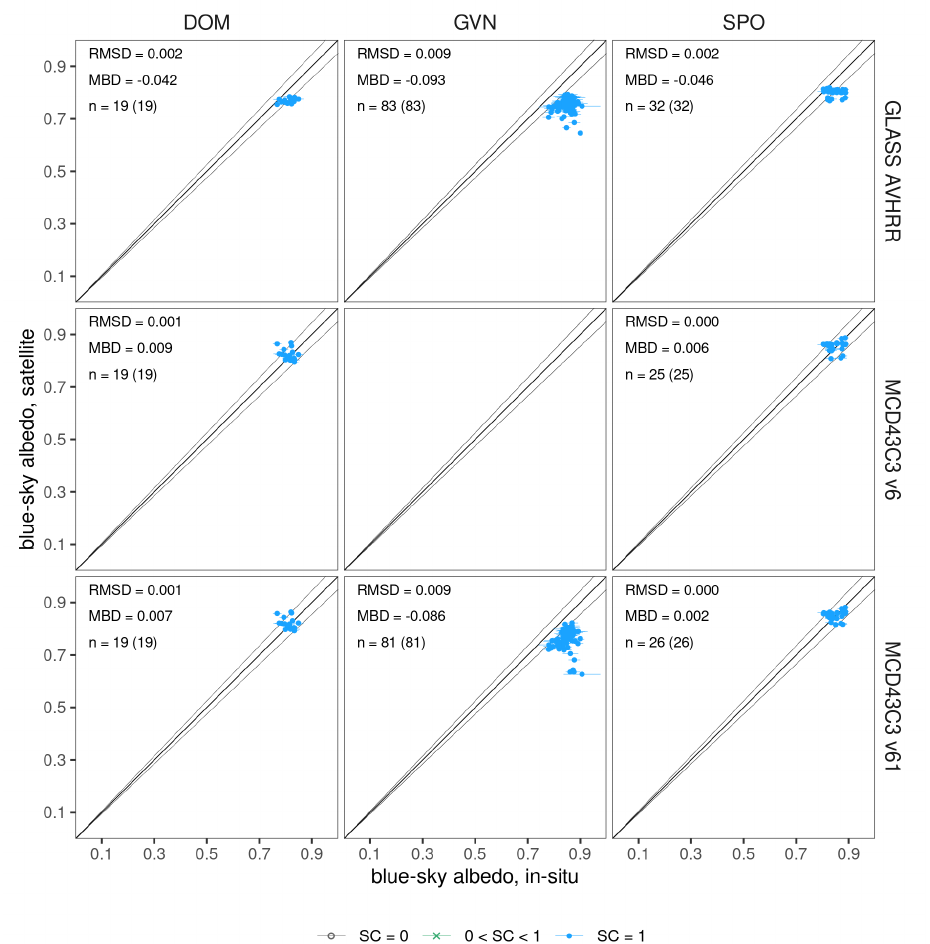
Figure 3. Scatter plot of satellite vs in situ monthly blue-sky albedo at BSRN Antarctic stations from 2000/02 to 2014/05. Point color shows monthly snow cover (SC). Error bars represent the mean absolute deviation of daily in situ albedo. Intervals show the GCOS uncertainty requirement of max ( 5%, 0.0025). RMSD , MBD , and n values correspond to SC = 1 conditions. The total number of points is shown in brackets. Blank panels correspond to stations not covered by the